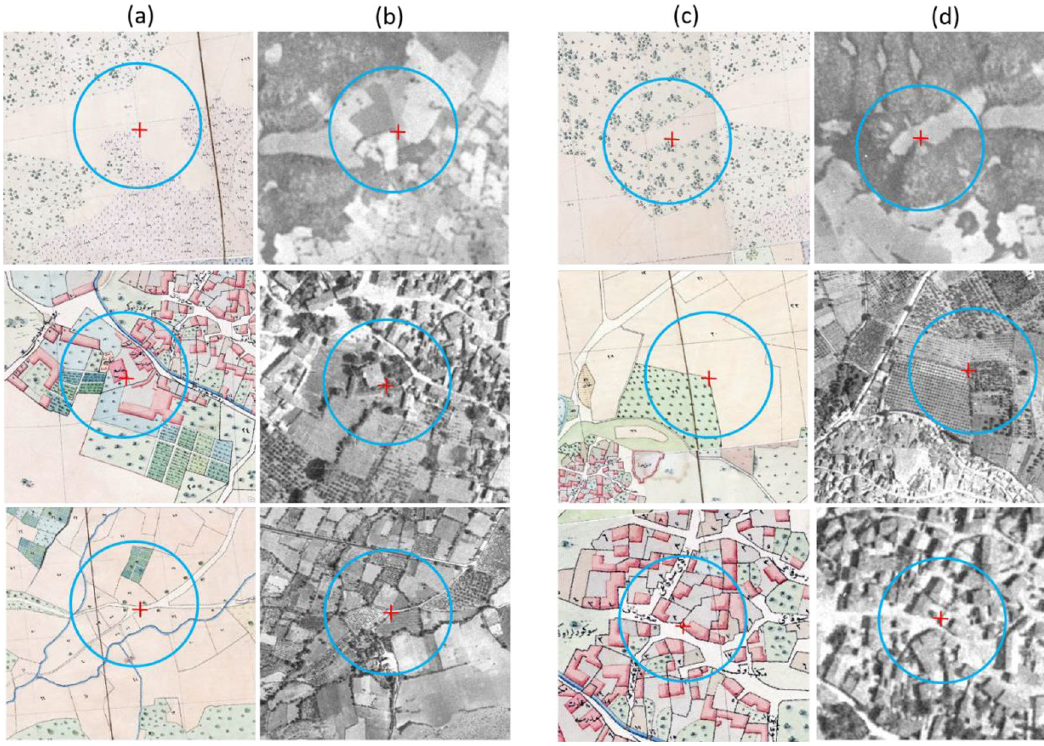
Figure 3. Examples of GCPs selection (red crosses in blue circles) on ( a ), ( c ) Cadastral maps and their counterparts on ( b ), ( d ) Aerial